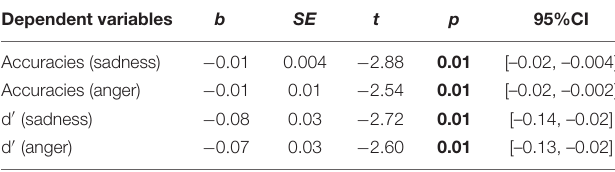
TABLE 4 | The interaction effects of group × depression in the DMTS task.